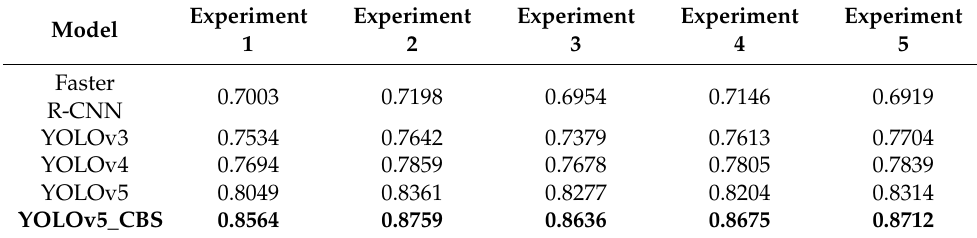
Table 5. F1 score of compared models on private dataset.